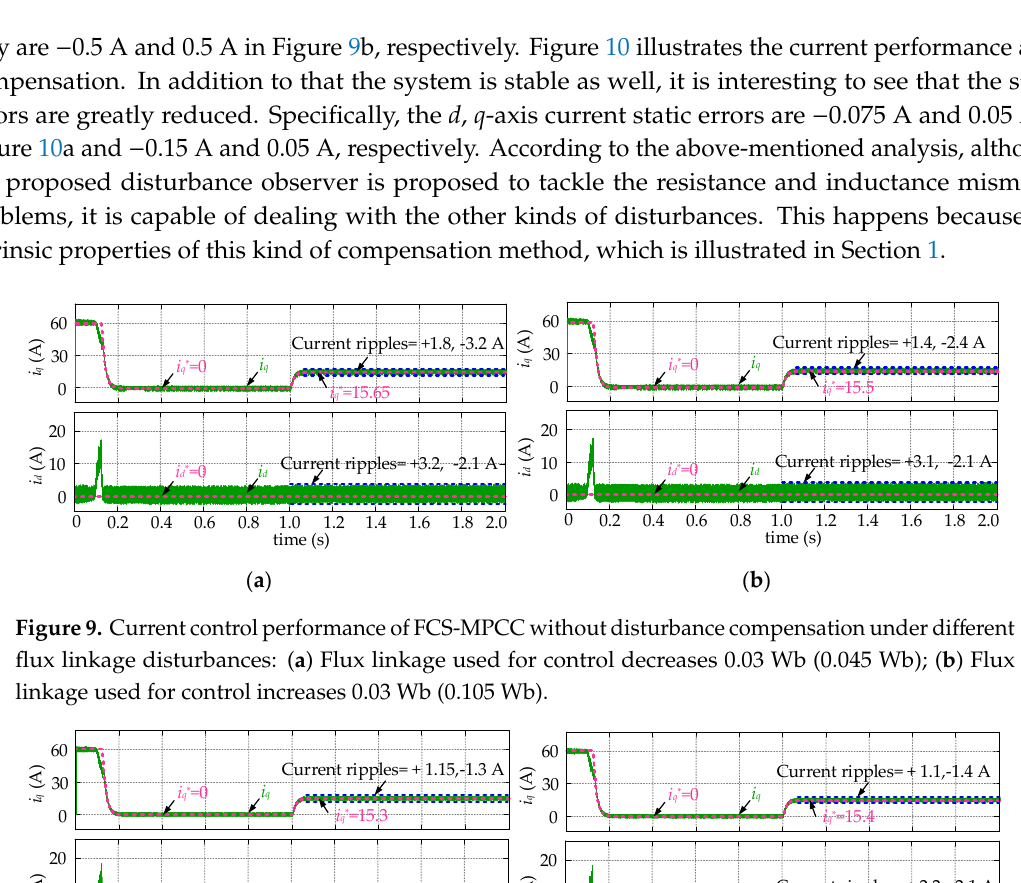
Figure 10. Current control performance of proposed FCS-MPCC with disturbance compensation under